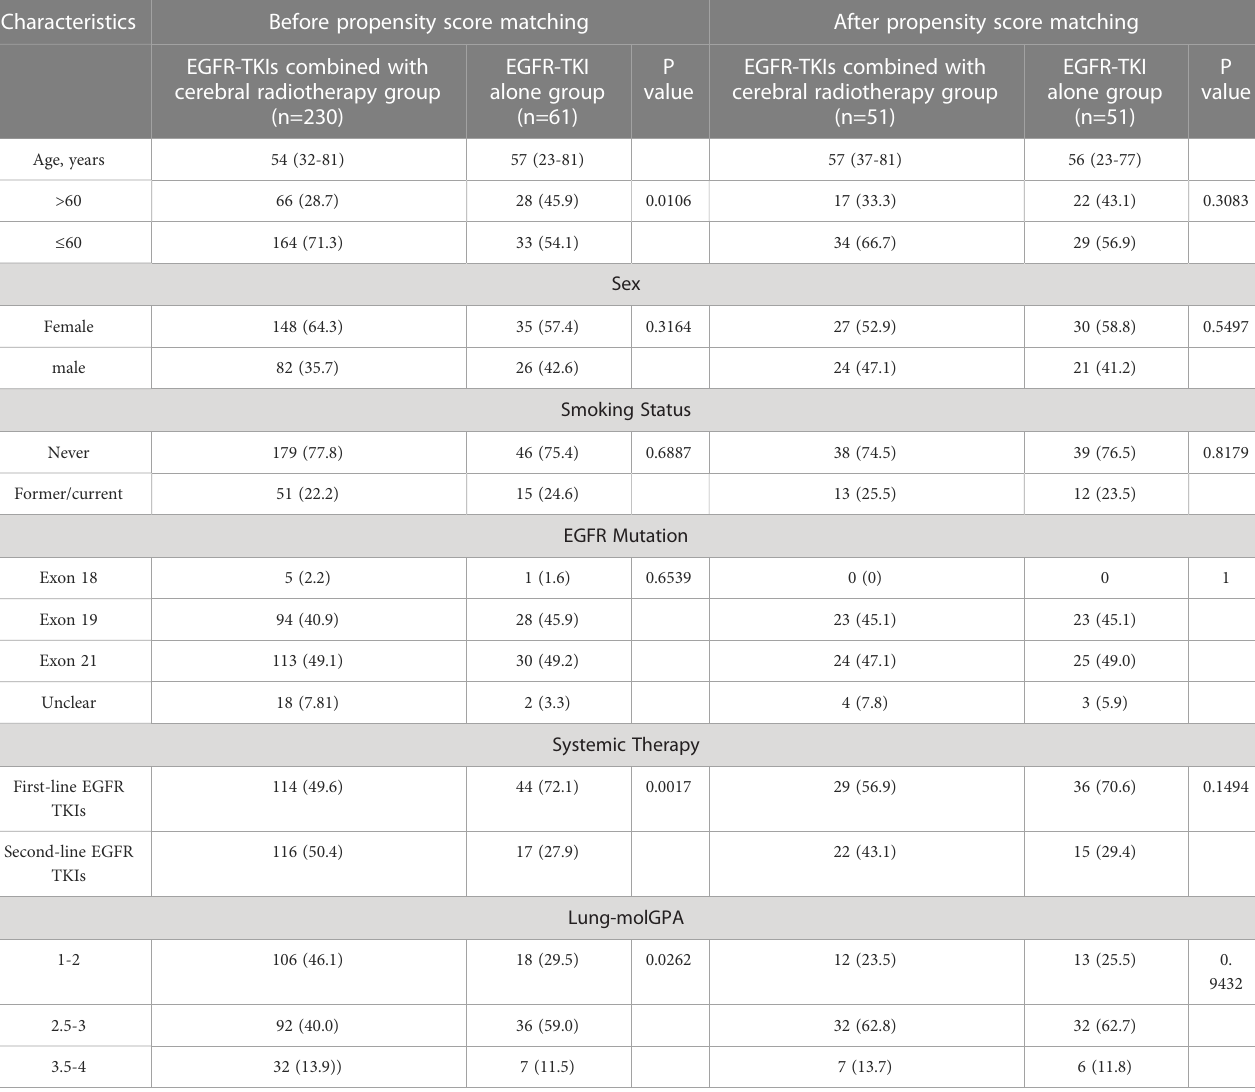
TABLE 1 Clinical features of patients in the EGFR-TKI alone group and EGFR-TKIs combined with cerebral radiotherapy group with chi-square test for Categorical Variables.